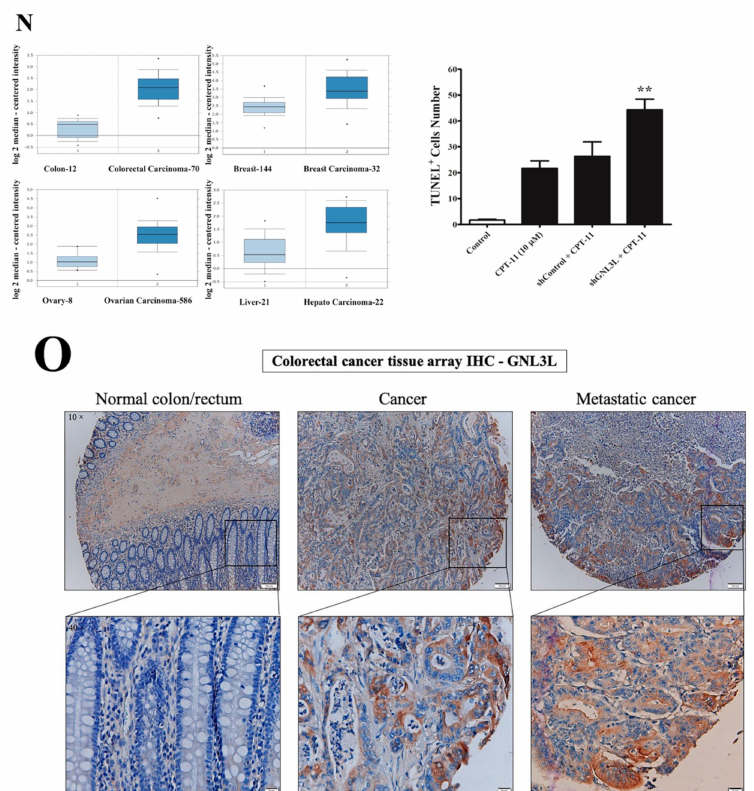
Figure 7. Silencing GNL3L imitates the e ff ect of proliferation, colony formation, and invasion / migration. Results from ( A ) cell proliferation (OD 570) and Western blotting ( B ) colony formation. ( C , D ) Transwell invasion / migration assays (upper & lower) showing that silencing of GNL3L inhibited cell proliferation; the level of GNL3L silencing e ffi ciency, colony formation, and invasion / migration compared to the control is presented (scale bar: 100 µ m). ( E ) Relative luciferase NF- κ B promoter signal unit reduction in GNL3L -silenced LoVo cells. ( F , G , H ) Tumor volume measurements. ( I , J ) Western blot and IHC analysis of GNL3L protein expression level, ( K ) IHC analysis of NF- κ B expression (scale bar: 50 µ m). shRNA-mediated silencing GNL3L in metastatic SW620 cell line. Results from ( L ) NF- κ B promoter assay, and ( M ) TUNEL assay (10 × ). ( N ) Results from the Oncomine database analysis of GNL3L expression levels. ( O ) Representative image showing an inverse correlation of GNL3L expression level between adjacent tissue and cancer or metastatic tissue as determined by IHC analysis using a commercial CRC array (US Biomax, Inc.) (scale bar: 20 µ m). (The results are presented as mean ± standard error of the mean ( n = 3). * p < 0.05, ** p < 0.01, *** p < 0.001 compared to